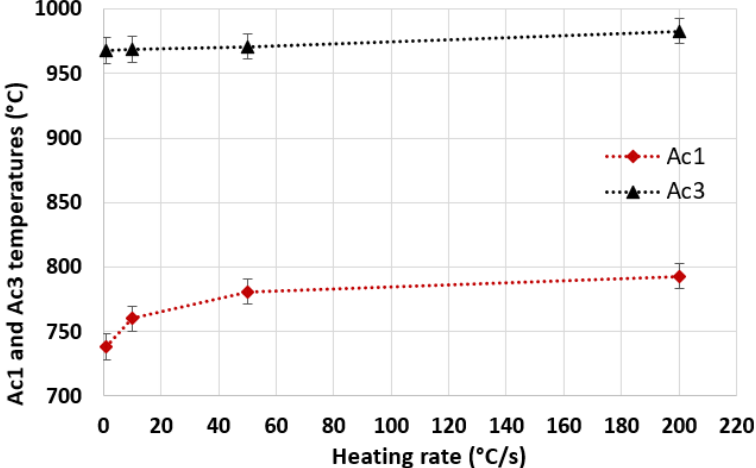
Figure 5. Effect of HV increase on Ac 1 and Ac 3 temperature variation (steel chemical composition 0.19%C + 0.5%Si + 1.61%Mn + 1.06%Al), peak temperature of 1100 °C, and cooling rate of 300 °C/s (data from [48]).